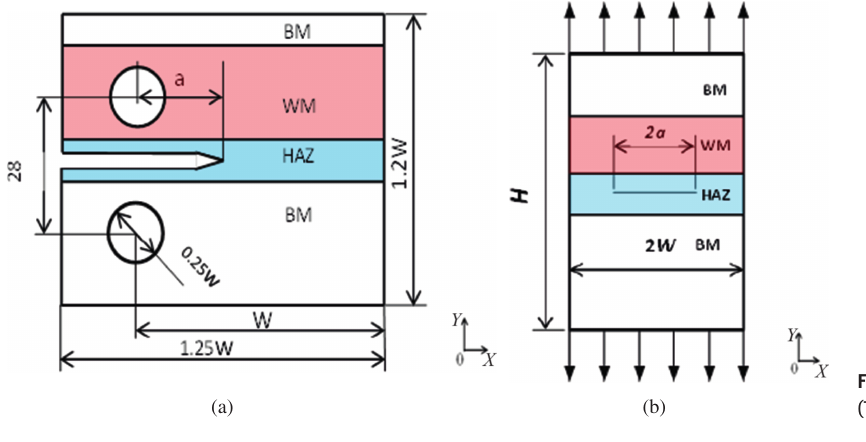
Figure 1: The geometries of C(T) (a) and M (T) (b)